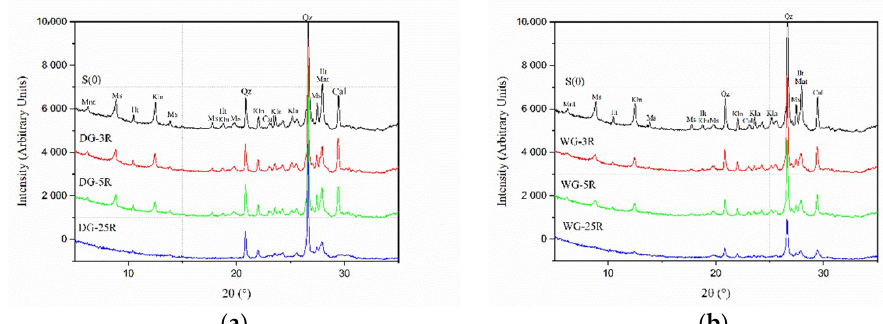
Figure 2. XRD diffraction patterns for different B/P ratio during grinding of a Swedish raw clay: ( a ) dry grinding process for samples S0, DG-3R, DG-5R and DG-25R; ( b ) wet grinding process for sample S0, WG-3R, WG-5R and WG-25R. (Kln-kaolinite, Mnt-Montmorillonite, Ms-muscovite, Ilt-illite, Qz-quartz, Cal-calcite).